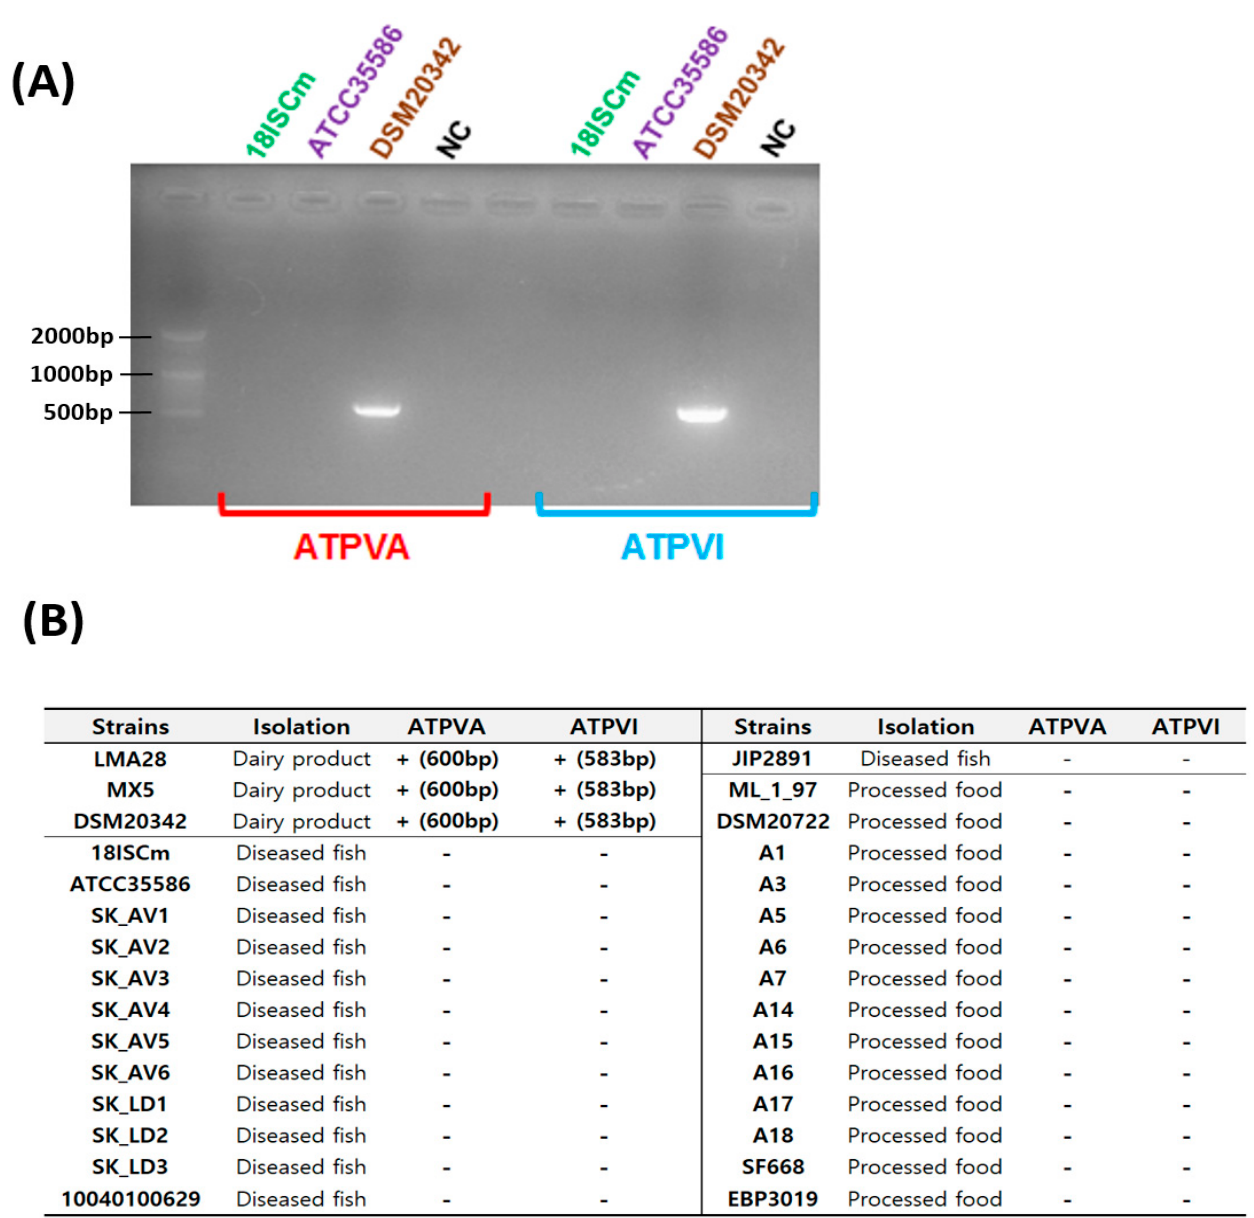
Figure 2. PCR products (ATPVA- and ATPVI-specific primers) using 18ISCm, ATCC35586, and DSM20342 genomic DNA ( A ). The results of in silico PCR for all 30 strains. The results of in silico PCR for all 30 strains isolated from dairy products, diseased fish, and processed food. + denotes positive amplification and the expected amplification size is indicated in the parentheses. - denotes no amplification in in silico PCR ( B ).